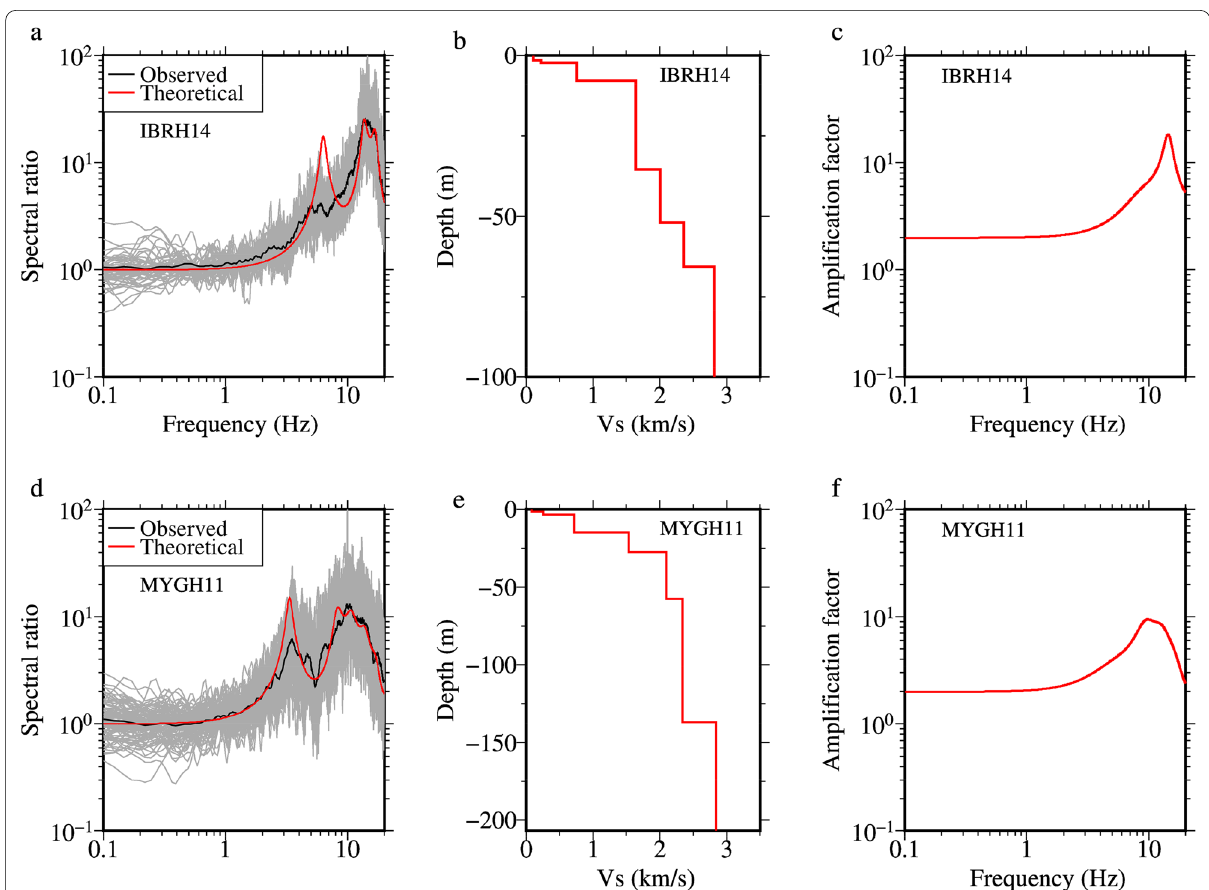
Fig. 3 a, d Surface-to-borehole spectral ratios (SBSR) at the IBRH14 and MYGH11 sites, respectively. Grey lines denote the SBSR for the individual earthquakes, while the black lines denote the mean values. The red lines denote the theoretical SBSR computed from the S-wave velocity models shown in the panels b and e , respectively. c, f Theoretical amplification factors at the IBRH14 and MYGH11 sites computed from the velocity models shown in the panels b and e , respectively. The theoretical values were computed using the propagator matrix method (Ch. 5, Aki and Richards 2002), assuming vertically propagating plane S wave. See Additional file 2 for the values of layer parameters used in the theoretical computation of the spectral ratios and amplification